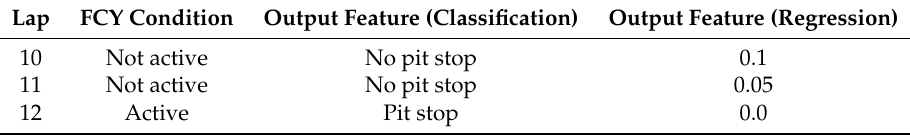
Table 4. Comparison of example output features in a classification and a regression